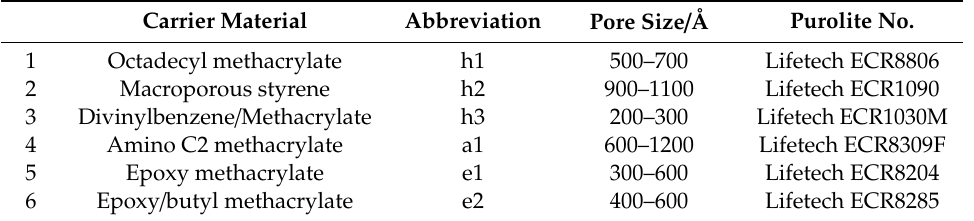
Table 1. Immobilization carrier used for the immobilization of OxdB ( Bacillus sp. OxB-1) or OxdRE ( Rhodococcus erythropolis ) purified enzymes.